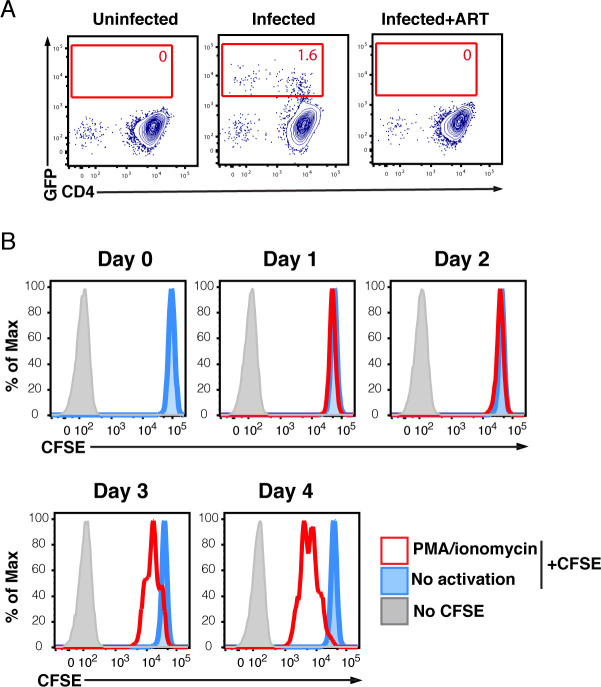
Establishing conditions for ex vivo reactivation of latent cells.(A) A combination cocktail of ART fully suppresses HIV infection. PHA-activated PBMCs were mock-treated or exposed to the CCR5-tropic HIV-1 reporter strain F4.GFP (Neidleman et al., 2017), either in the absence or presence of a cocktail of ART drugs targeting HIV-1 Reverse Transcriptase, Protease, and Integrase, as well as the fusion inhibitor T20. Cells were then analyzed using FACS 4 days later for infection levels. The proportion of HIV-infected (GFP+) cells is indicated within the gates. Results are pre-gated on live, singlet CD3+CD8- cells. (B) PMA/ionomycin stimulation of T cells for 2 days does not induce proliferation. PBMC-derived T cells were stained with CFSE and then mock-treated or stimulated with PMA/ionomycin for the indicated number of days before FACS analysis. Cells not stained with CFSE were also analyzed at each time point. The results demonstrate that proliferation begins to occur on day 3 post-stimulation. All stimulations in this study were conducted for less than 2 days when T cells had not yet proliferated.